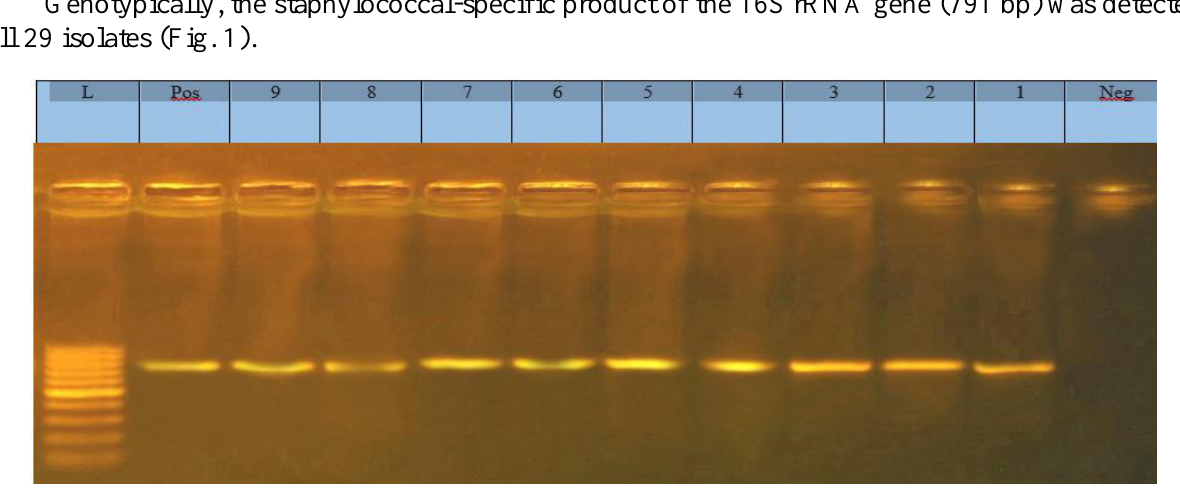
Fig. 1: Agarose gel electrophoresis of 16 S rRNA gene PCR products from S. aureus isolates. Lane L: 100 bp DNA size marker, Lane pos: S. aureus positive control product, lanes 1-9: PCR products of 10 S. aureus test isolates (791 bp) and lane Neg.: negative control (master mix without DNA